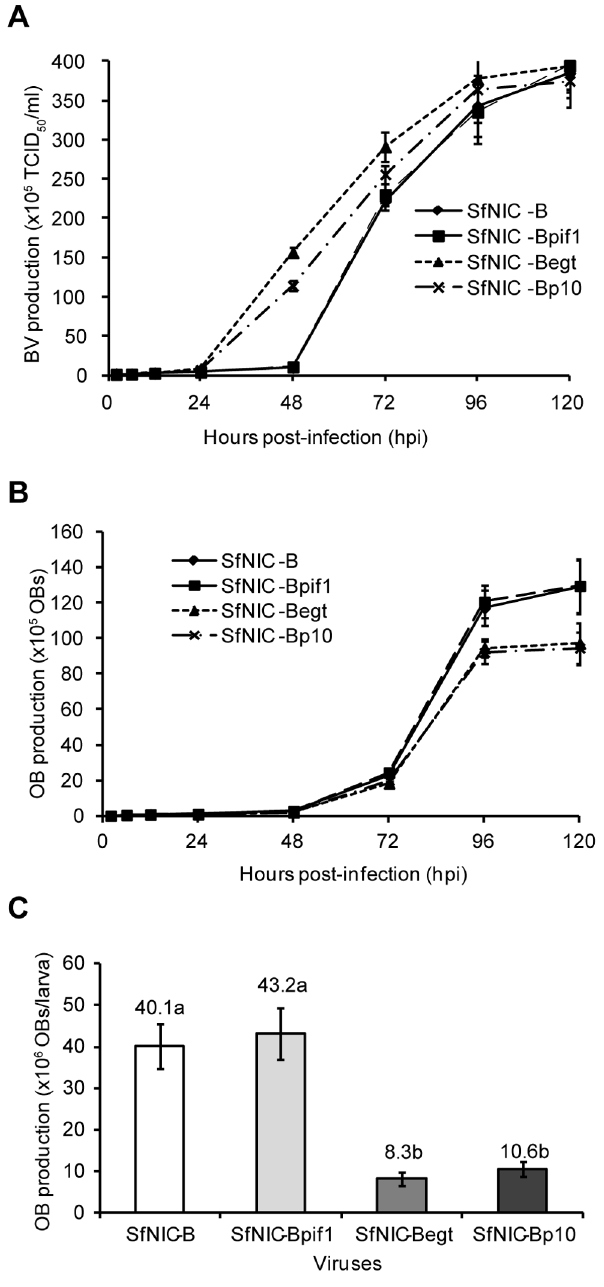
Figure 2. Virus production dynamics. A) Budded virus (BV) production in Sf9 cells by one-step growth curve analysis. 3 6 10 5 cells were infected at 10 MOI using BV originating from SfNIC-B and SfNIC- Bpif1, SfNIC-Begt and SfNIC-Bp10 recombinant viruses. Supernatants harvested at indicated time points post infection were subjected to titer determination on Sf9 cells by end-point dilution. Each data point represents the average titer derived from three independent infections. The experiment was performed three times. Asterisks below hours-post infection values indicate significant differences in BV production between the viruses at indicated times. B) OB production values of SfNIC-B and SfNIC-Bpif1, SfNIC-Begt and SfNIC-Bp10 recombinant viruses at different times post infection in Sf9 cells (OBs/cell). Groups of 3 6 10 5 cells were infected at 10 MOI with BV originating from SfNIC-B and SfNIC-Bpif1, SfNIC-Begt and SfNIC-Bp10 recombinant viruses. Cells were collected at indicated time points post infection and subjected to OB production determination by direct counting in a